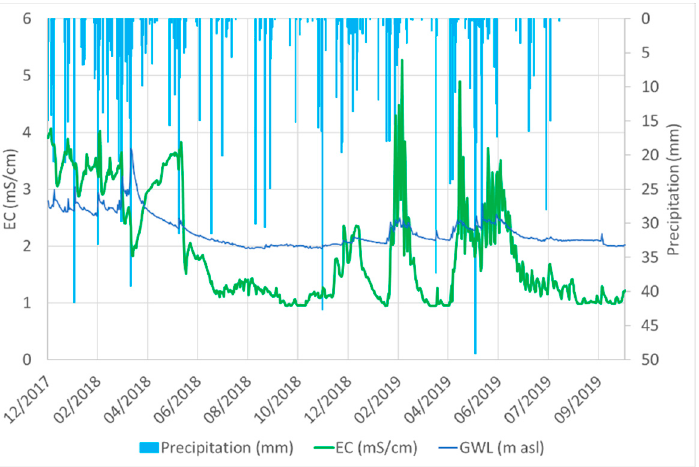
Figure 9. Precipitation rates, electrical conductivity, and groundwater level on the Boljkovac water supply facility.